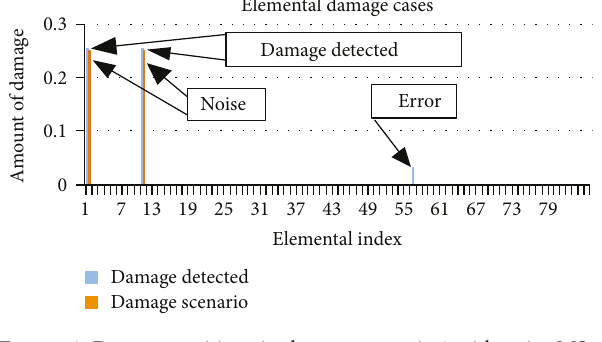
Figure 9: Damage positions in damage scenario 2 with noisy MSs.